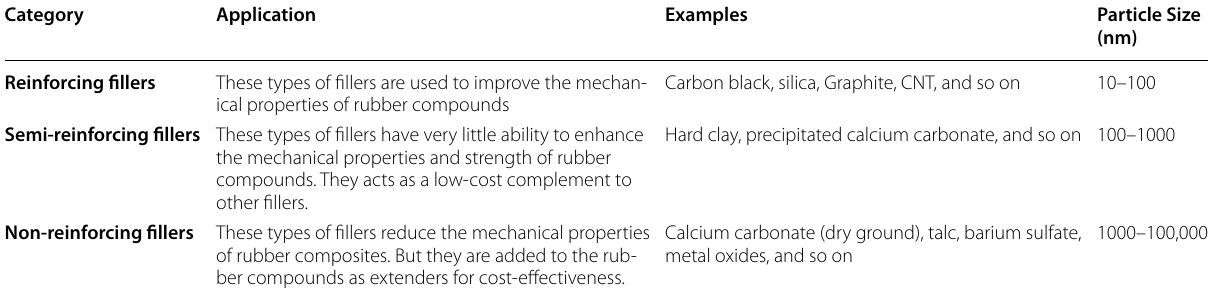
Table 1 Classification of fillers and their applications